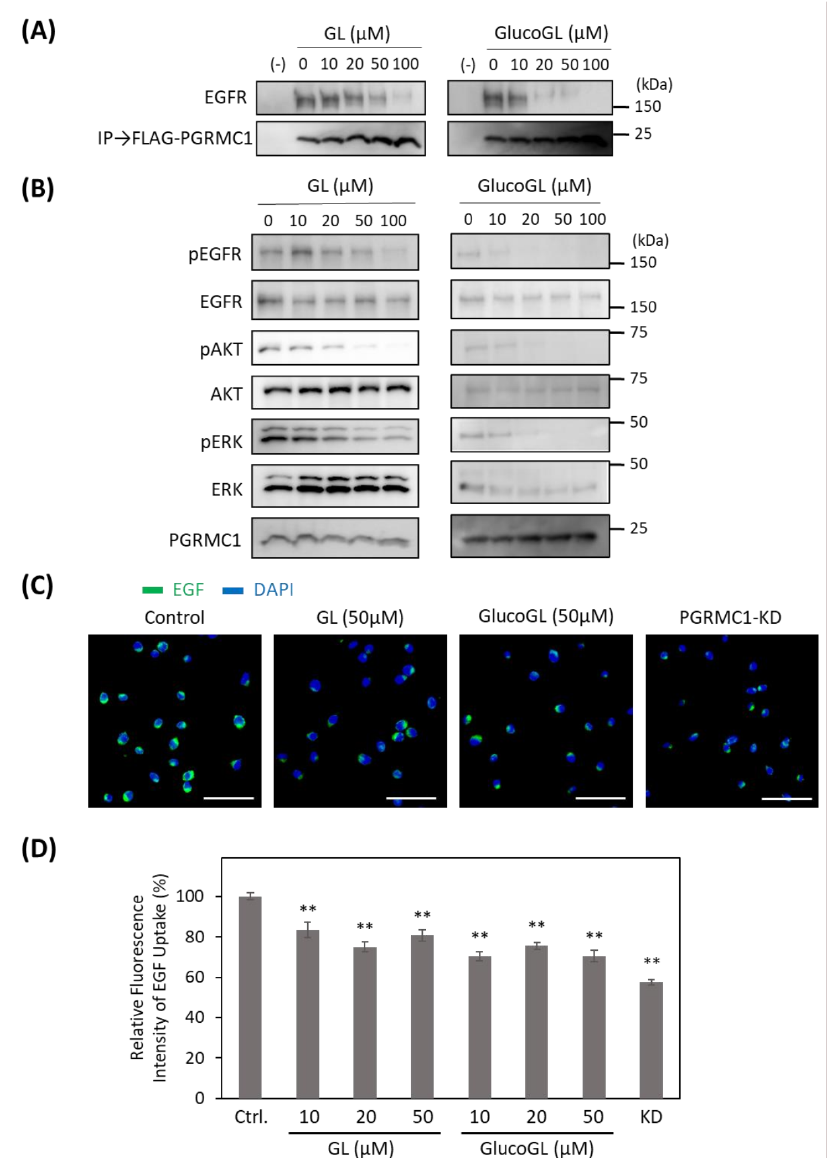
Figure 4. GL derivatives inhibit the interaction between PGRMC1 and EGF receptor (EGFR), and suppress EGFR signaling. ( A ) Co-immunoprecipitation assay of the binding between PGRMC1 and EGFR. FLAG-PGRMC1 was overexpressed in HCT116 cells treated for 12 h with either GL or GlucoGL. The cell lysates were immunoprecipitated using anti-FLAG antibody-fixed beads. Co- immunoprecipitated proteins (FLAG-PGRMC1 and EGFR) were detected through western blotting using anti-FLAG or anti-EGFR antibodies. ( B ) HCT116 cells treated with either GL or GlucoGL were incubated with EGF for 5 min, and components of the EGFR signaling pathway were detected using western blotting. ( C ) HCT116 cells treated with or without GL, GlucoGL, or PGRMC1-knockdown (KD) cells were incubated with Alexa Flour 488 EGF complex. Fluorescence microscopic images of the incorporated EGF (green) and diamidino phenylindole (DAPI) (blue) are shown (Scale bar; 100 µ m). ( D ) Flowcytometric analysis of EGF uptake in HCT116 cells. HCT116 cells treated with or without GL, GlucoGL, or PGRMC1-KD cells were incubated with Alexa Flour 488 EGF complex for 5 min. The bars show the mean fluorescence intensities (per 10,000 cells) ( n = 6). Data represent the mean ± SE. Statistical analysis was performed using Dunnett’s test. ** p <